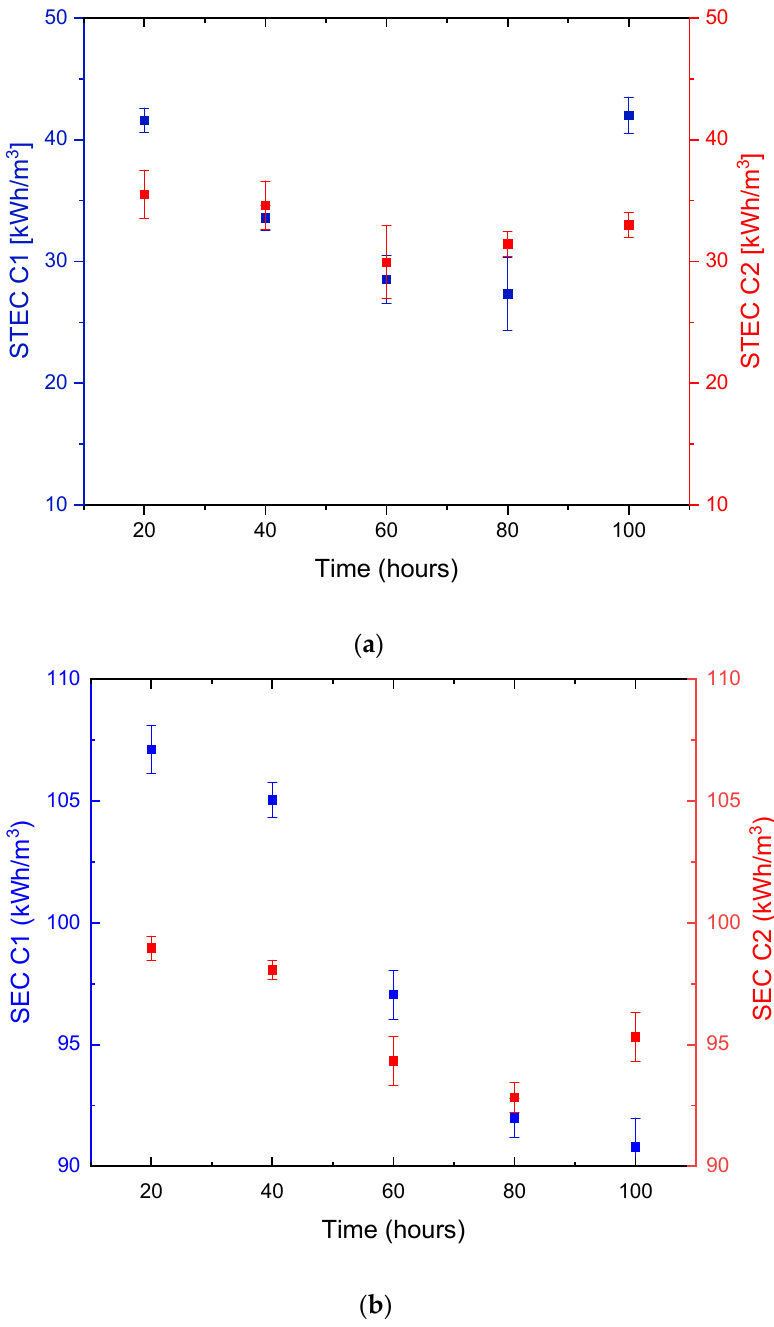
Figure 13. Influence of different feed concentrations on ( a ) specific thermal energy consumption and ( b ) specific energy consumption for the entire MD operation process in pilot scale.